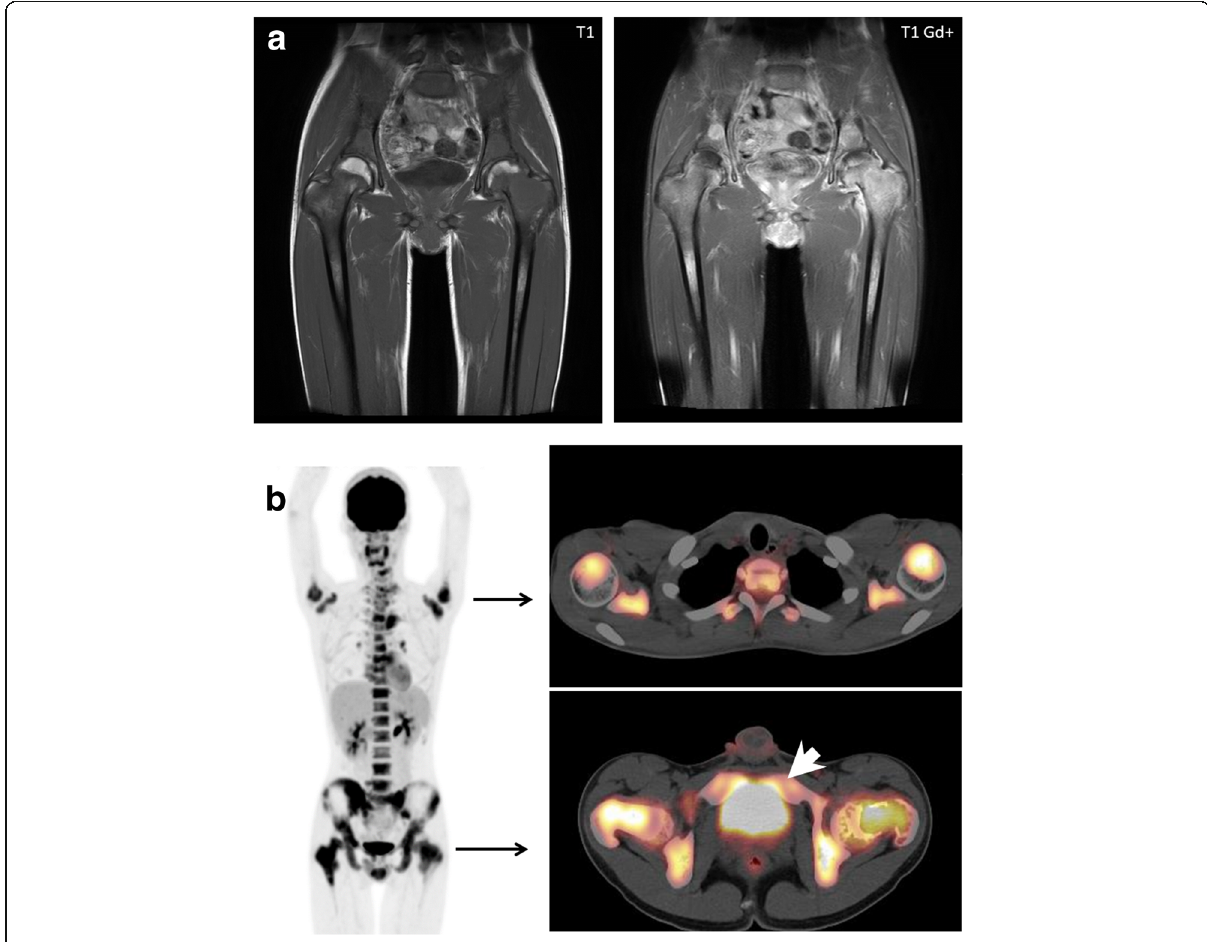
Fig. 1 Clinical imaging. a Magnetic resonance imaging. Tumors replaced massive amounts of tissue at the bilateral femoral heads, which showed low intensity on T1-weighted images (left) with gadolinium enhancement (right). b 18 F – FDG-PET/CT. Uptake of 18 F – FDG was symmetrical in the bilateral upper arms and femoral heads, and in the pelvis. Several areas of spotty uptake were also observed in the vertebrae. A transverse image at the level of the upper arm head (right top). A transverse image at the level of the femoral head (right bottom). The white arrow head indicates uptake of perineal muscle, which was recognized as a primary site. (Abbreviations: 18 F – FDG, 1 8 F – fludeoxyglucose; PET, positron emission tomography; CT, computed